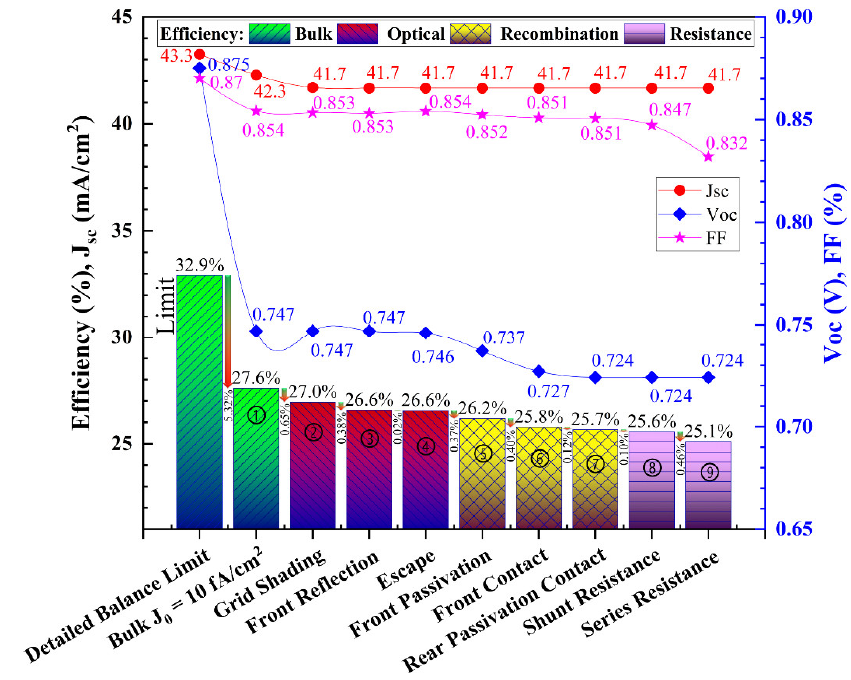
Figure 11. Loss factor analysis from bulk to optical, recombination, and resistances. Table 1. Loss factor analysis of efficiency through various materials.